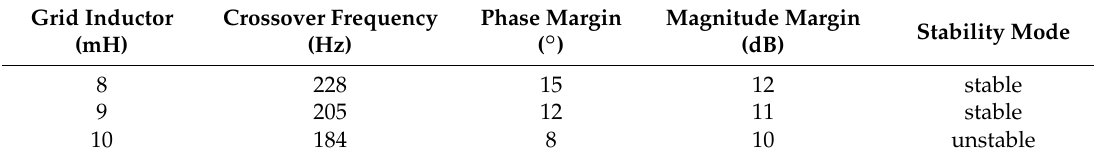
Table 4. Stability state when increasing the current controller bandwidth by 40%.